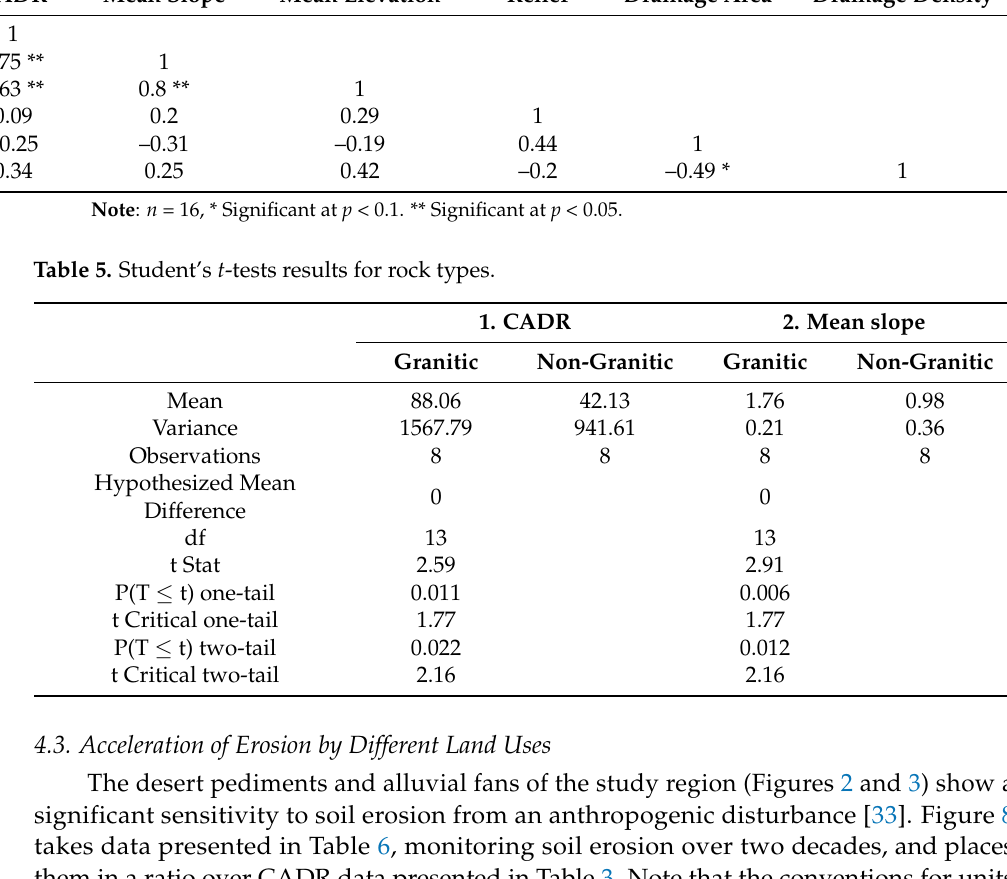
Table 4. Correlation matrix between CADRs and key stock tank catchment variables. CADR